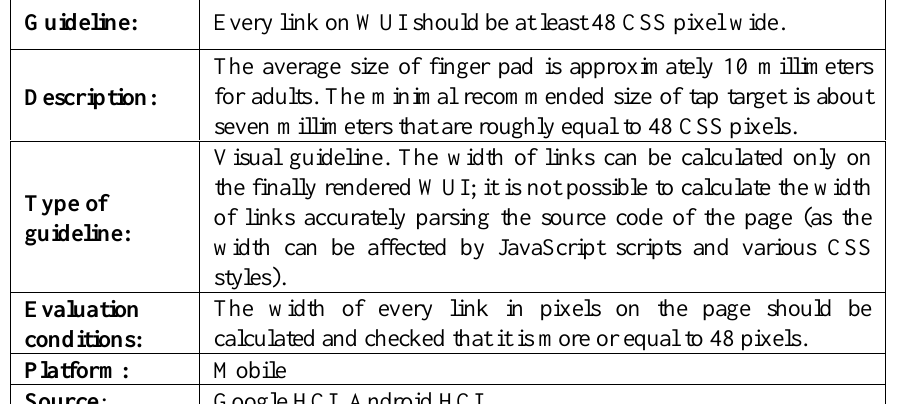
Table 1. Example guideline on link width targeting mobile platforms presented in a text format